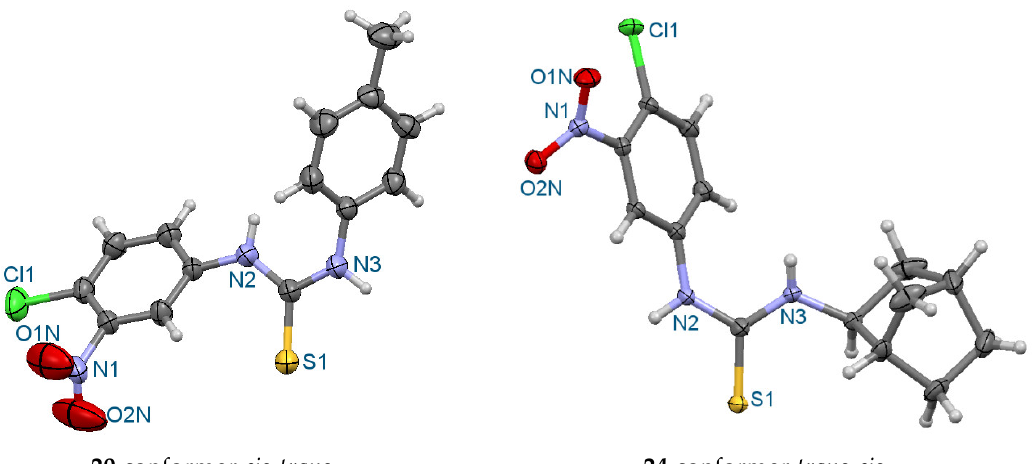
Figure 1. Perspective view of molecules 20 and 24 . Conformers are defined by relative orientation of 4‐chloro‐3‐nitrophenyl and aryl/alkyl groups to thiourea C=S bond.